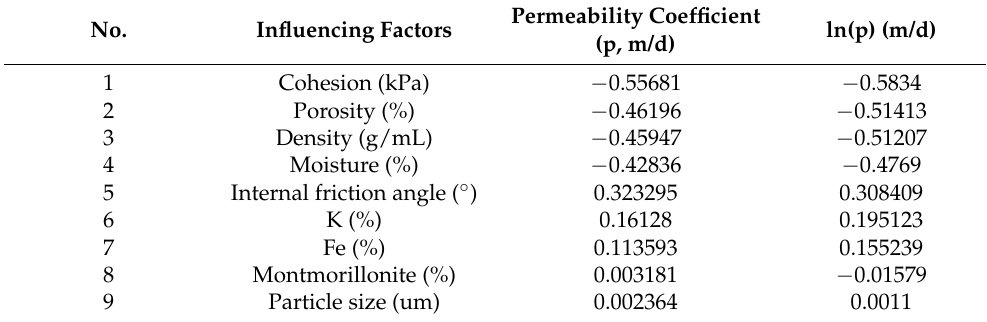
Multivariate regression